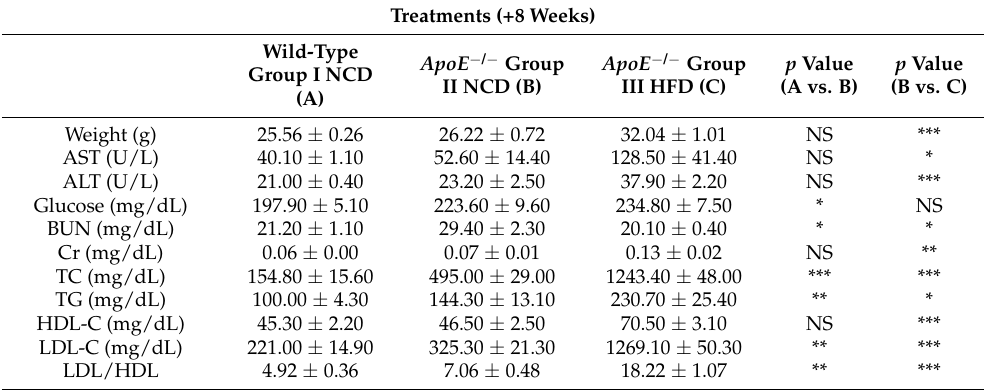
Table 2. Biochemical parameters after 8 weeks of respective treatment in all the three groups of